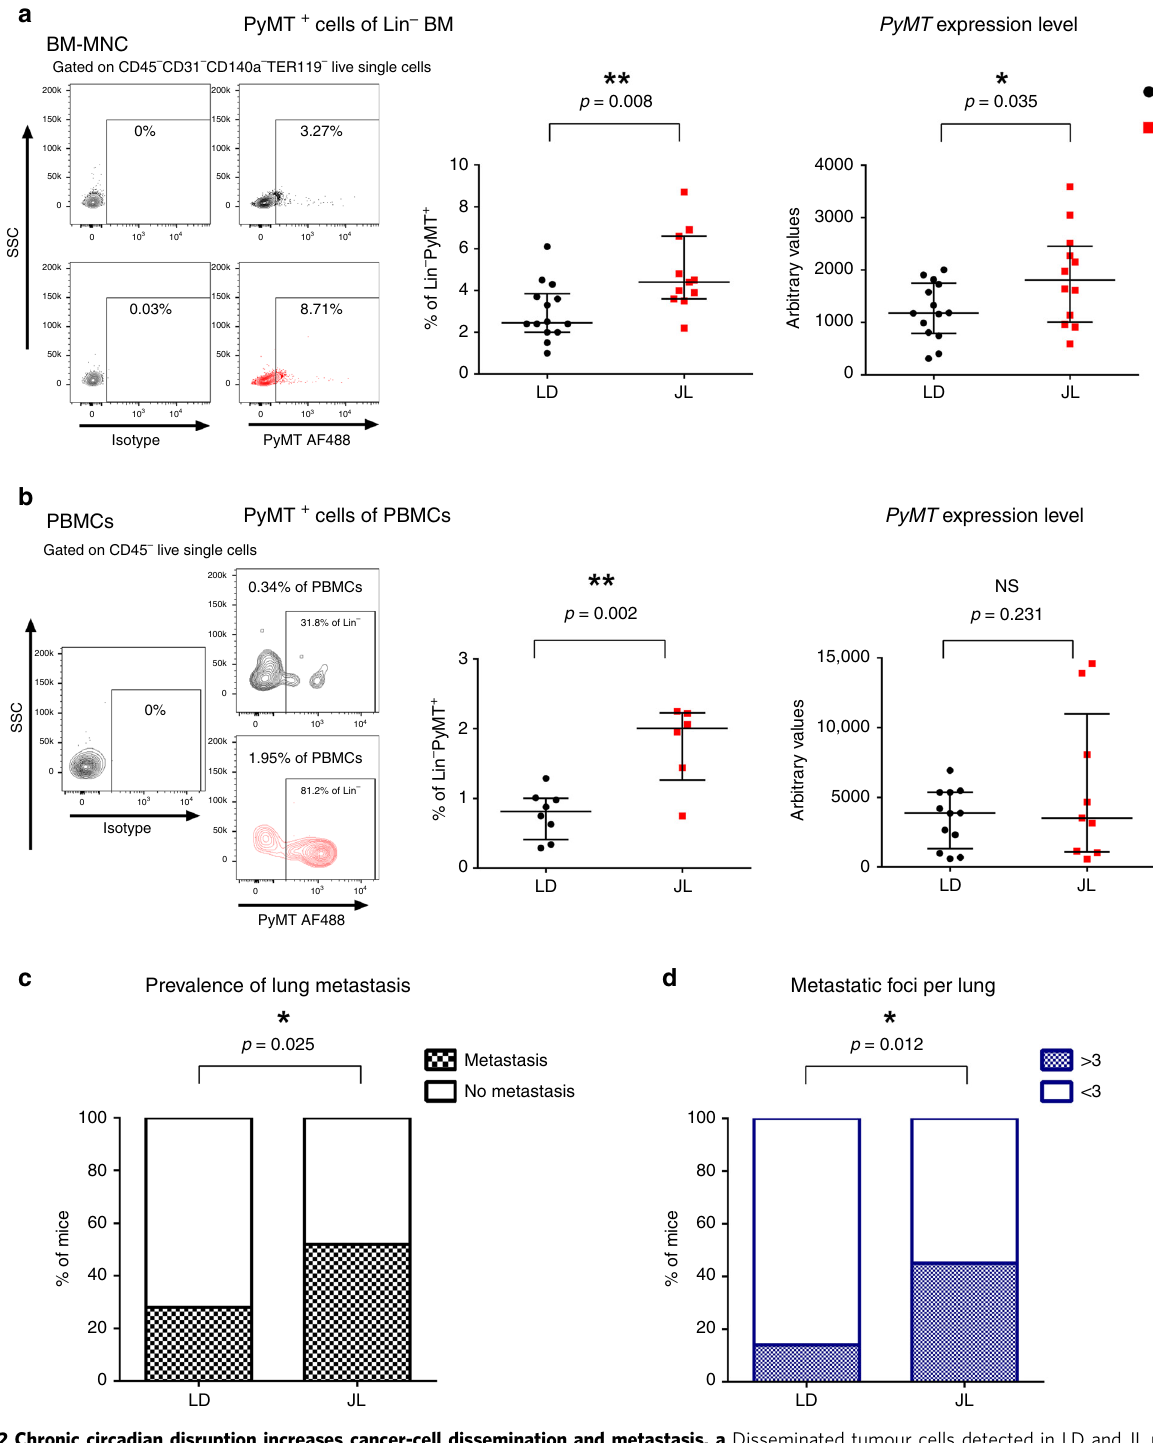
Fig. 2 Chronic circadian disruption increases cancer-cell dissemination and metastasis. a Disseminated tumour cells detected in LD and JL mice at 16 weeks of age by fl ow cytometry (left, LD n = 14 and JL n = 11) and real-time PCR (right, LD n = 14 and JL n = 12) of bone marrow mononucleated cells (BM-MNC). Representative fl ow cytometry plots showing intracellular PyMT staining of CD45 − CD31 − CD140a − Ter119 − live BM-MNC cells. Data are presented as scatter dot plots with lines indicating the median with interquartile range (error bars). P -values are calculated from an unpaired two-sided t -test. b Circulating tumour cells in peripheral blood mononuclear cells (PBMCs) detected by fl ow cytometry (left; LD: n = 8 and JL: n = 6) and real-time qPCR (right; LD: n = 12 and JL: n = 9) in mice at 16 weeks of age. Representative fl ow cytometry plots showing intracellular PyMT staining of CD45 − live PBMCs (SSC: side scatter). Data are presented as scatter dot plots with lines indicating the median with interquartile range (error bars). P -values are calculated from an unpaired two-sided t -test. c Prevalence of lung metastasis in LD ( n = 25) and JL ( n = 21) cohorts at 16 weeks of age. Data represent the percentage of mice with metastasis in both conditions, P -value obtained from a binomial two-sided test. d Number of metastatic foci per lung in LD ( n = 25) and JL ( n = 21) mice at 16 weeks of age. Data represent the percentage of mice with >3 or <3 metastatic foci in both conditions. P -value obtained from a binomial two-sided test. Indicated ( n ) represents the number of independent experiments as biological